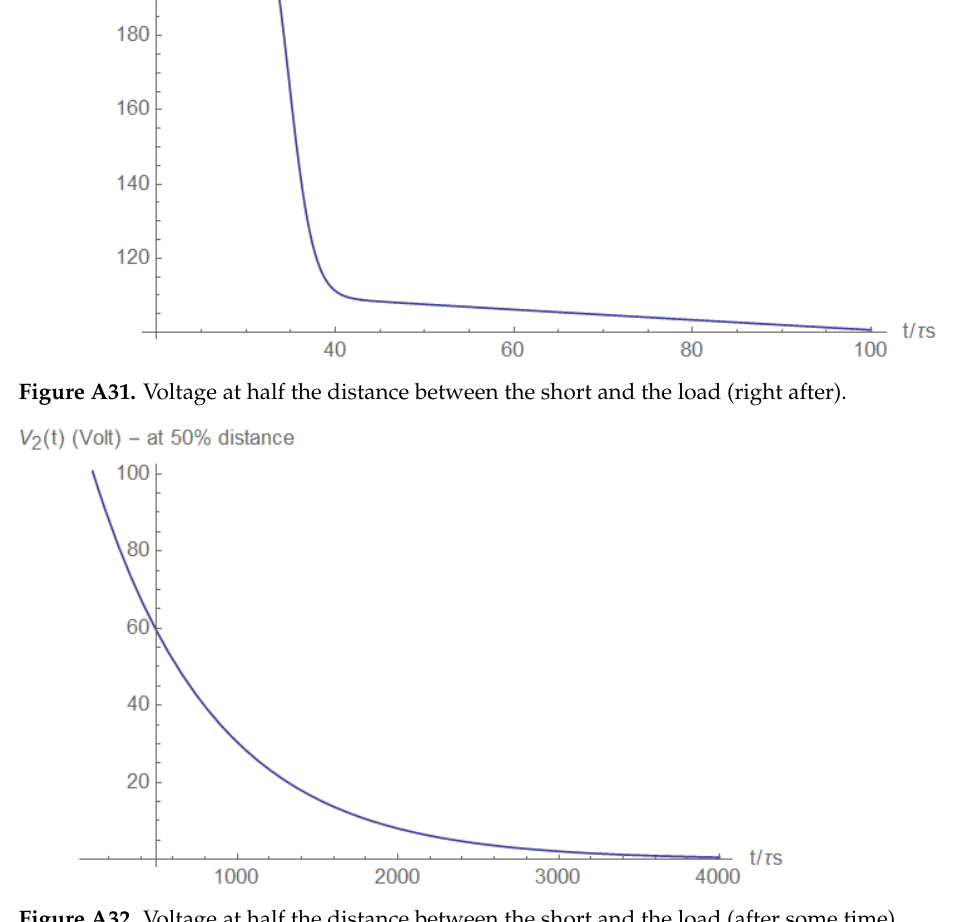
Figure A32. Voltage at half the distance between the short and the load (after some time). The voltage derivative displays a pulse behavior (Figure A33), and thus, in this case, a first derivative will suffice and a second derivative is not needed.